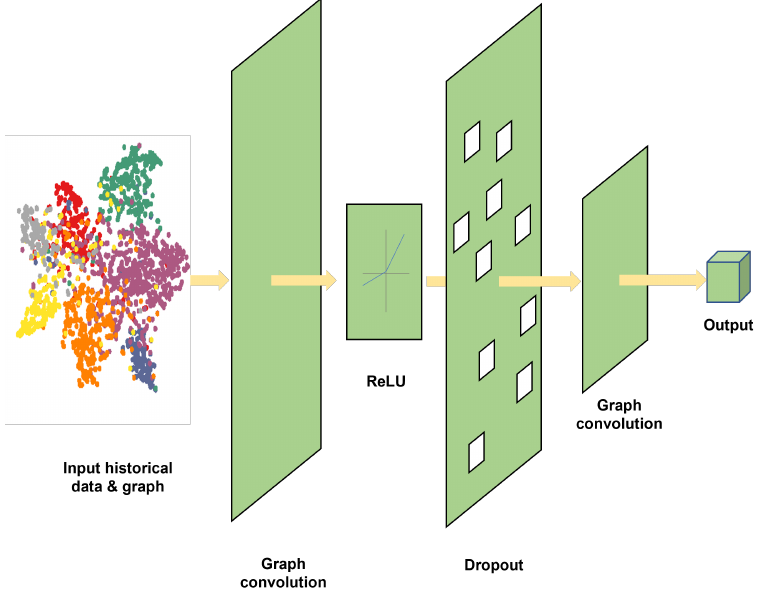
Figure 4. GCN layer